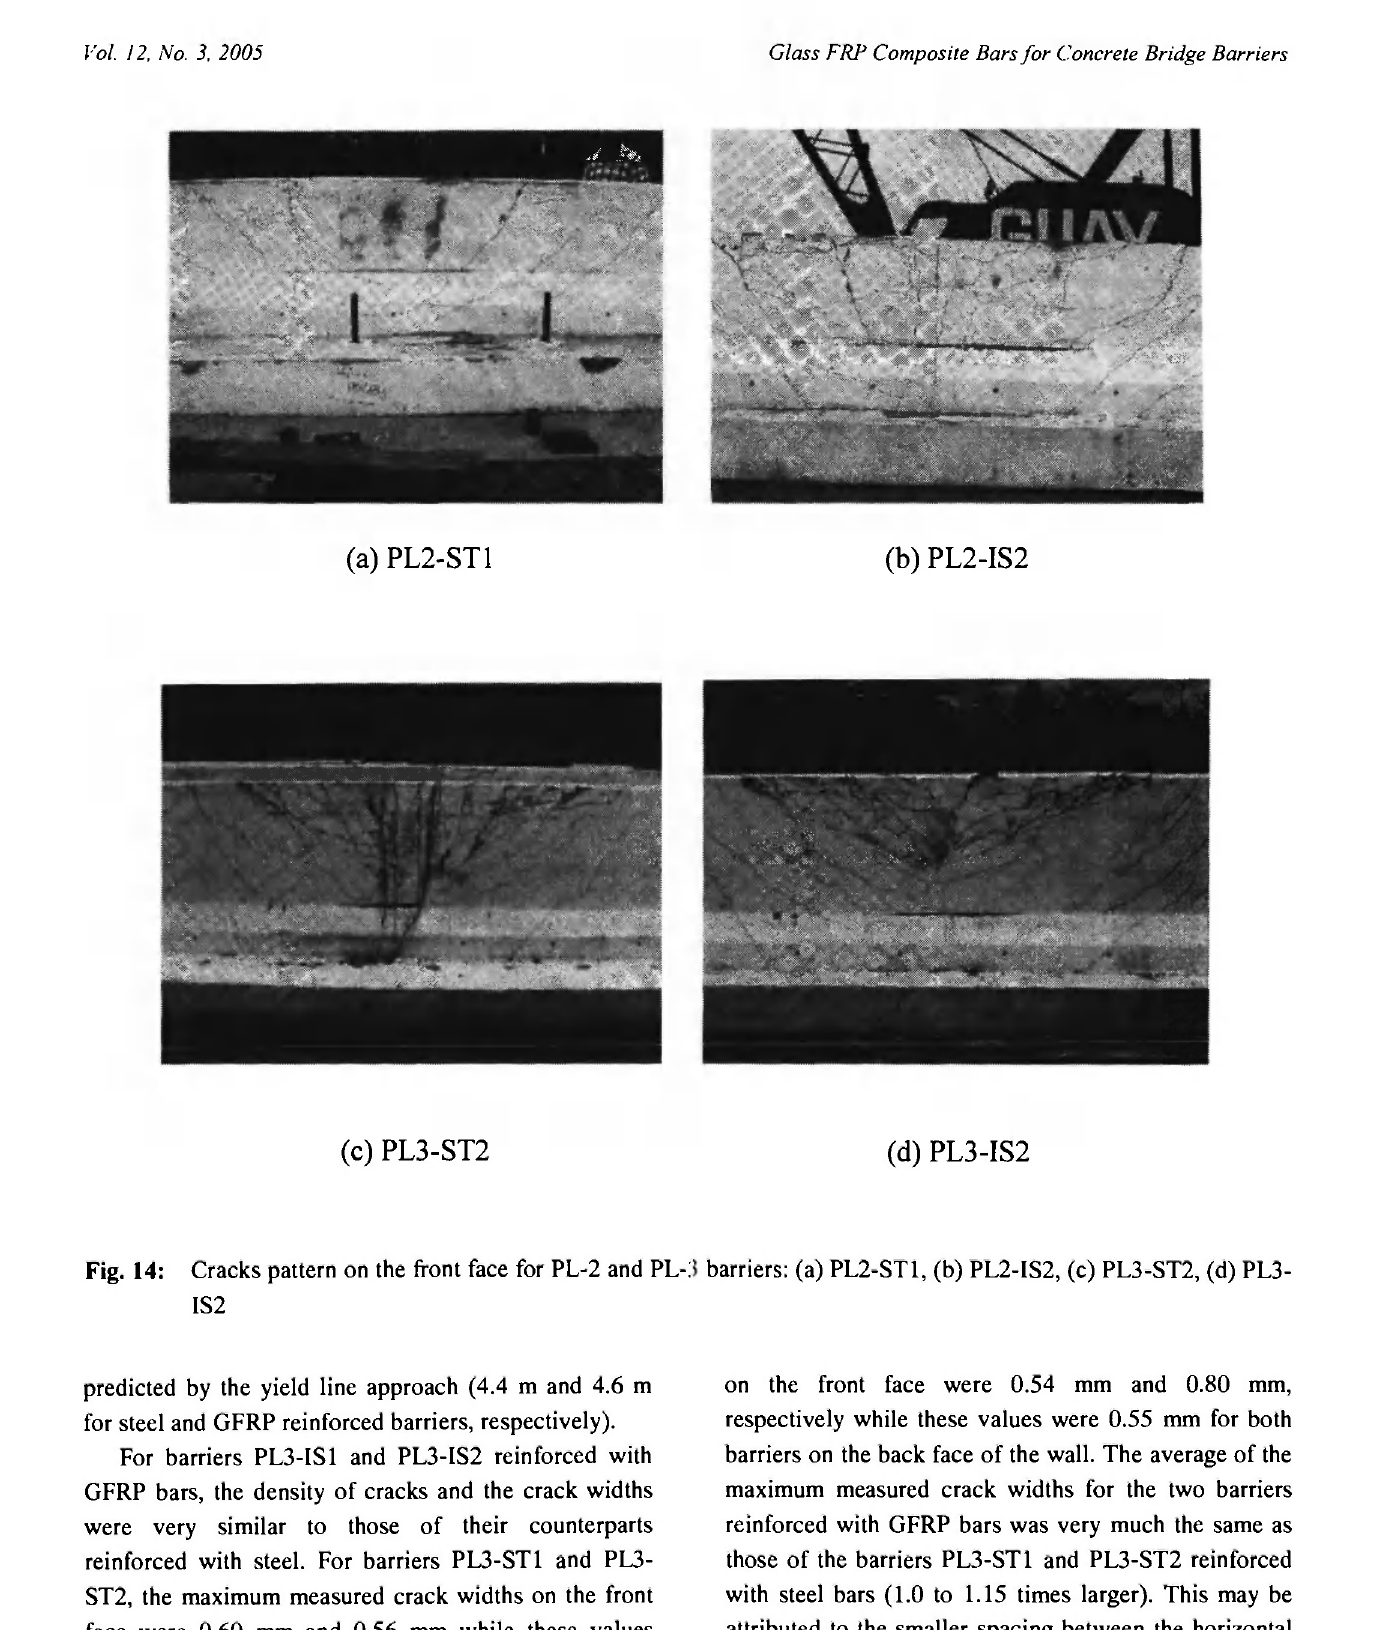
on the front face were 0.54 mm and 0.80 mm, respectively while these values were 0.55 mm for both barriers on the back face of the wall. The average of the maximum measured crack widths for the two barriers reinforced with GFRP bars was very much the same as those of the barriers PL3-ST1 and PL3-ST2 reinforced with steel bars (1.0 to 1.15 times larger). This may be attributed to the smaller spacing between the horizontal bars than that of type PL-2 barriers. Figure 15 shows the final crack pattern on the back face of PL-2 and PL-3